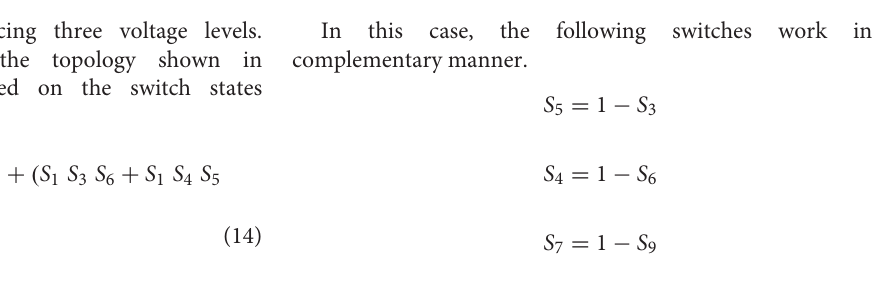
which are responsible for producing three voltage